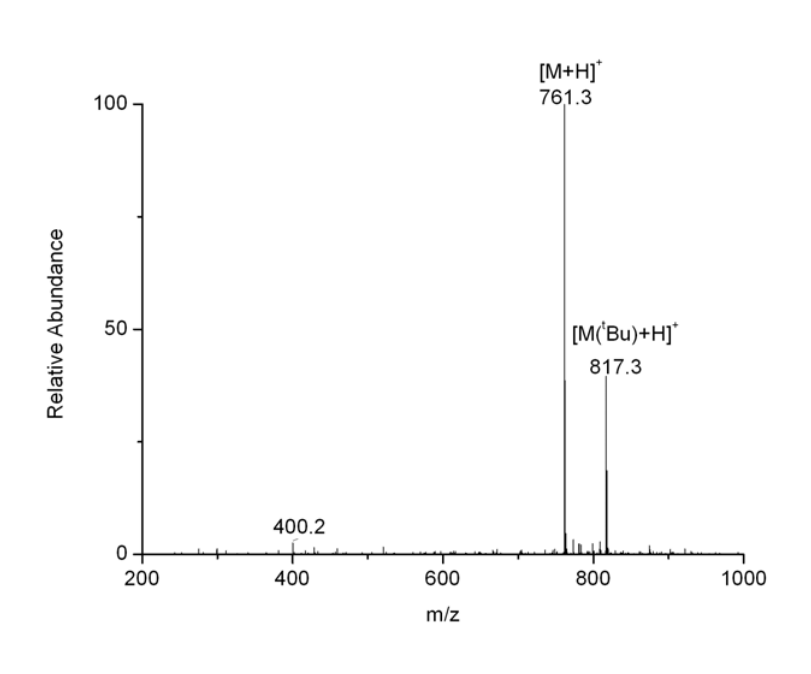
Fig. 8 ESI full scan spectrum of crude heptapeptide 1 without complete deprotection of t